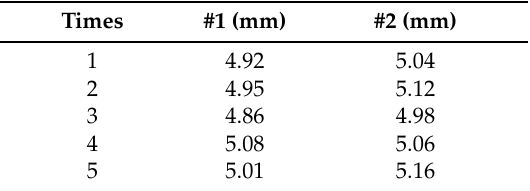
Table 1. Crack length sizing results of specimen 1.